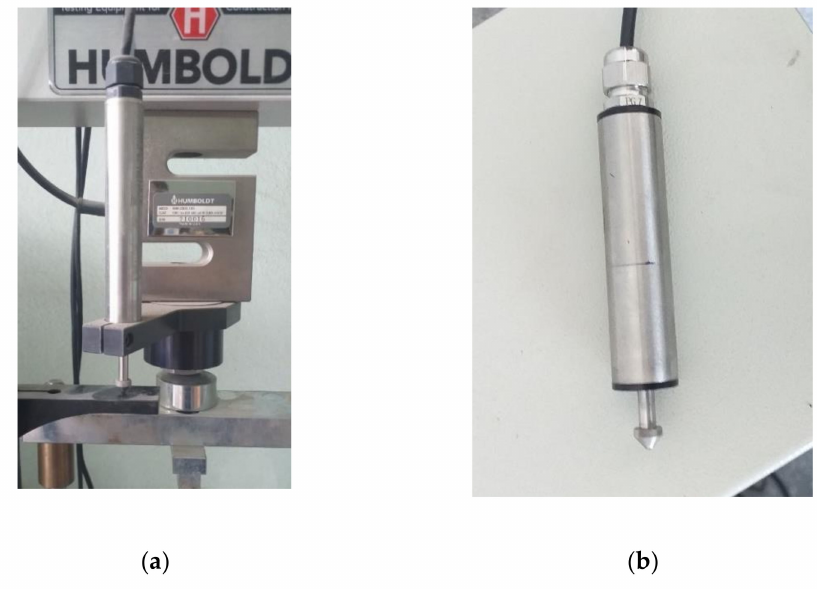
Figure 1. ( a ) Piston displacement measuring adapter; ( b ) linear strain gauge (photo: K.